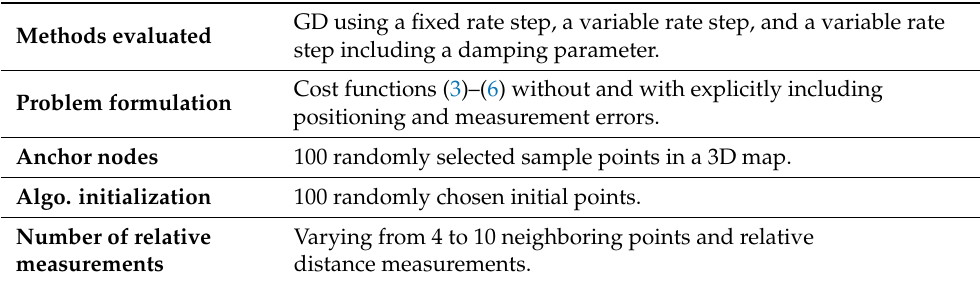
Table 1. Overview of the evaluated methods and the varied parameters in the simulations. Methods